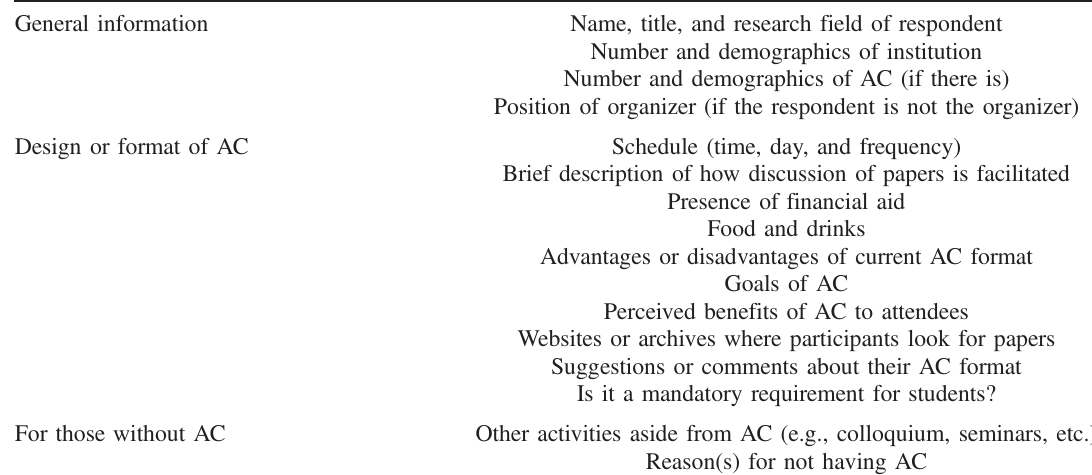
TABLE I. Elements of AC that we asked from the respondents in our initial survey. General